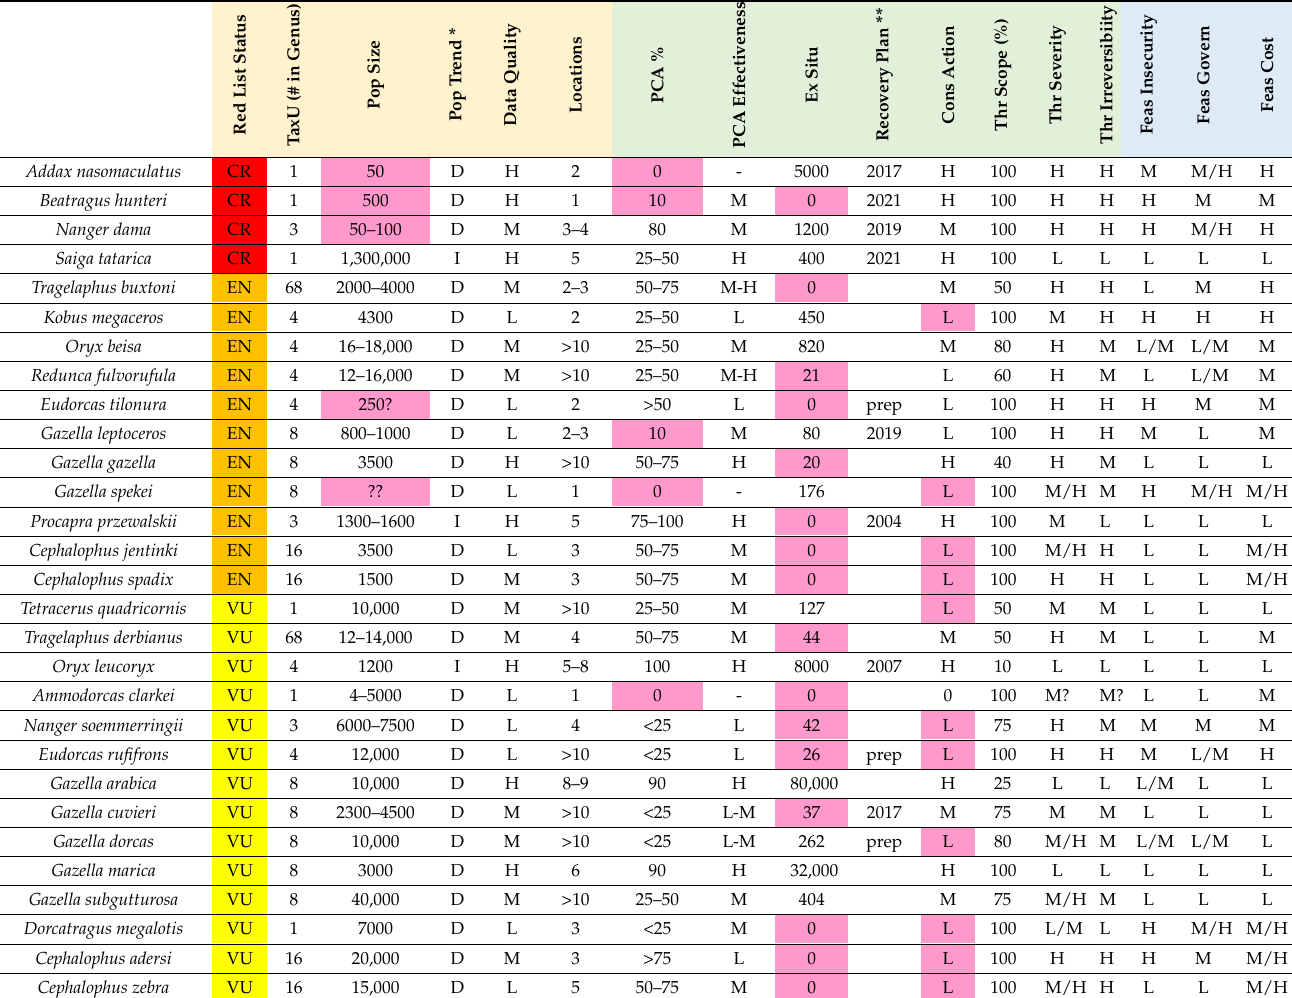
Table 3. ASG prioritization template and metrics for the 29 key species. Peach heading color indicates Red List demographic, and evolutionary distinctiveness variables; pale green is conservation and threat factors; and pale blue variables are feasibility categories. Red indicates Critically Endan- gered, orange Endangered, and yellow Vulnerable under Red List Status. The pink highlighted cells indicated variables important for the highest priority species. * Under Population Trend D is decreasing and I is increasing. ** Under Recovery Plan the year indicates the date of publication of the action plan/conservation strategy/recovery plan and prep indicates that a plan or strategy is under development. Under Population size, ? indicates an uncertain estimate and ?? denotes no reliable